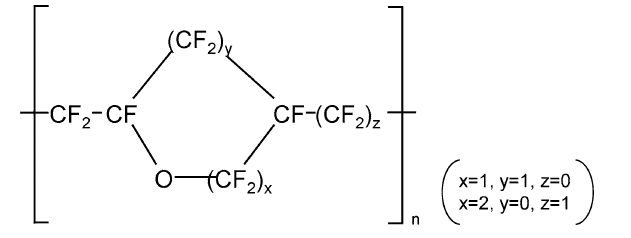
Figure 2. Chemical structure of Cytop.